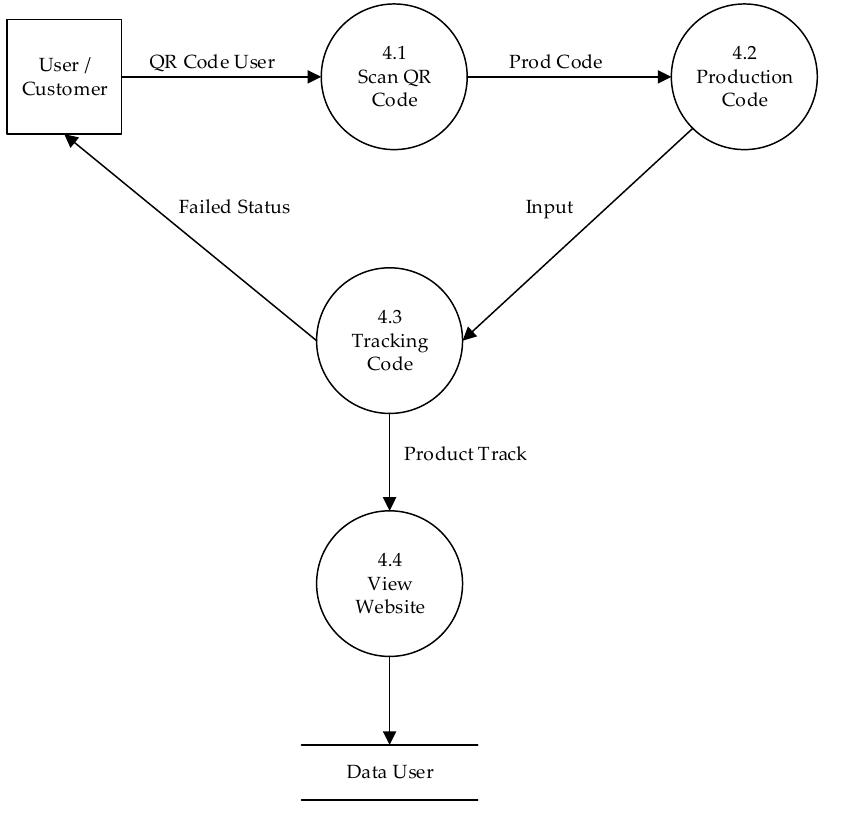
Figure 9. Diagram 4 level 2.